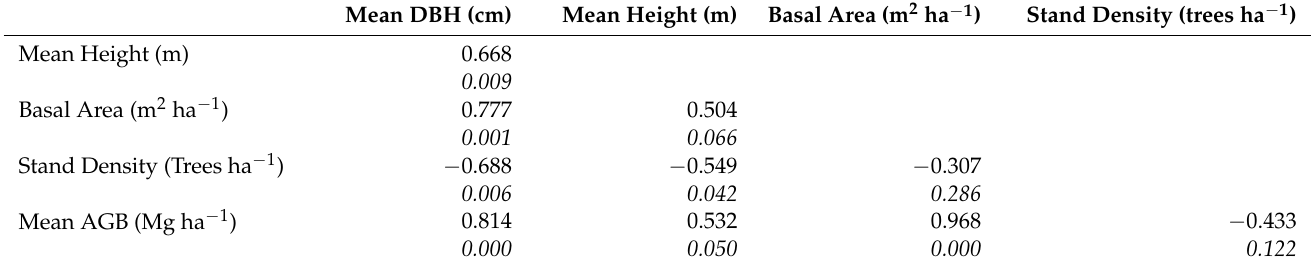
Table A3. Results from the Pearson correlation analysis of mean DBH (cm), mean height (m), mean showing the Pearson correlation values and the p